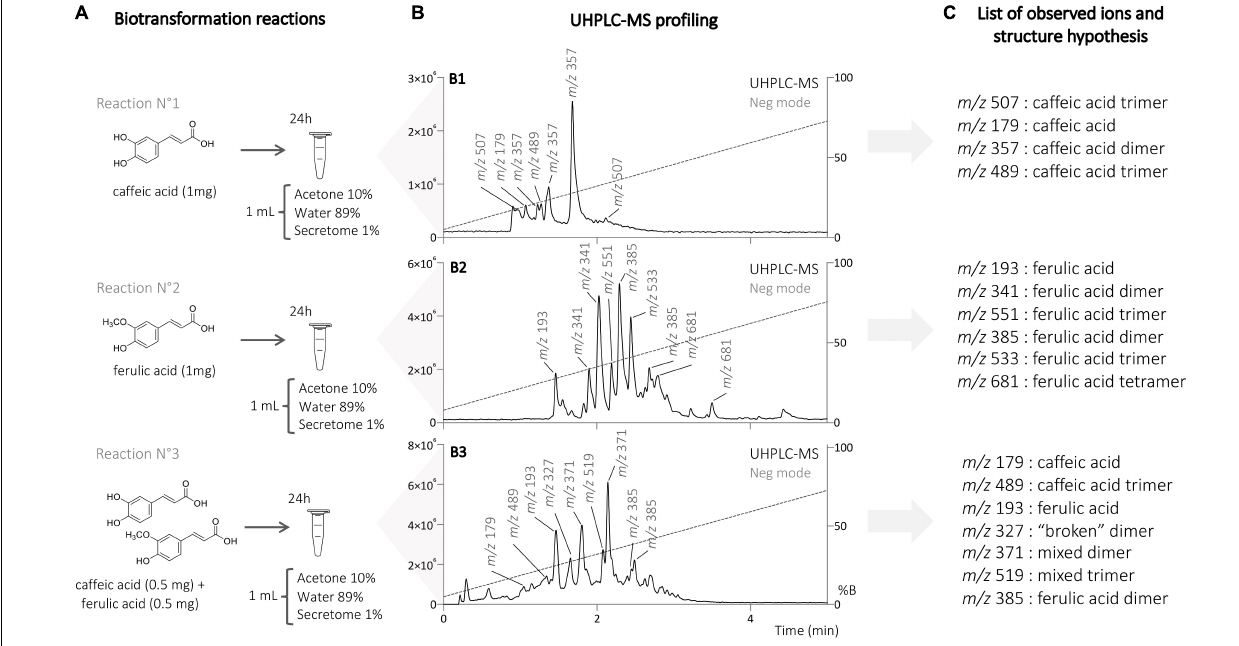
FIGURE 2 | (A) Biotransformation reactions on caffeic acid, ferulic acid, and mixture of both acids with the enzymatic secretome of B. cinerea . (B) UHPLC-MS profiling of the different reactions on the analytical scale with the top-scan m/z for the main peaks. (C) List of the observed ions and subsequent hypotheses about their chemical identity.